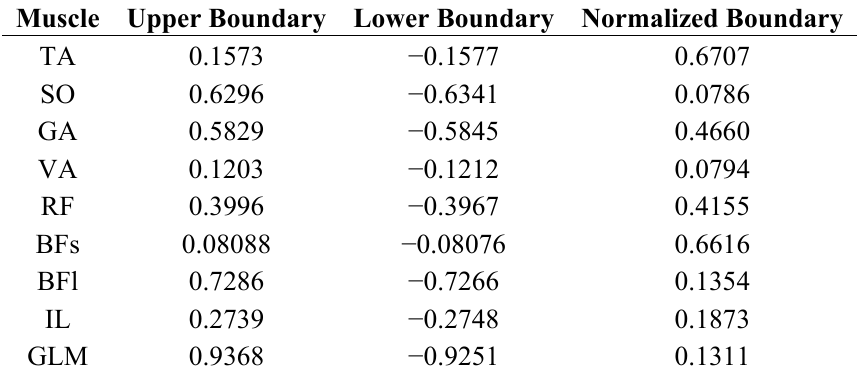
Table 3. Upper, lower and normalized boundaries for the nine muscle